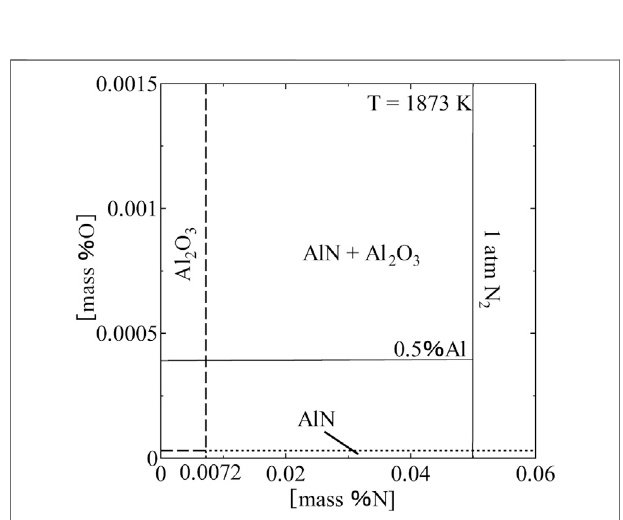
FIGURE 12 | Precipitation conditions of AlN inclusions in Fe-Al-2.0Mn system.